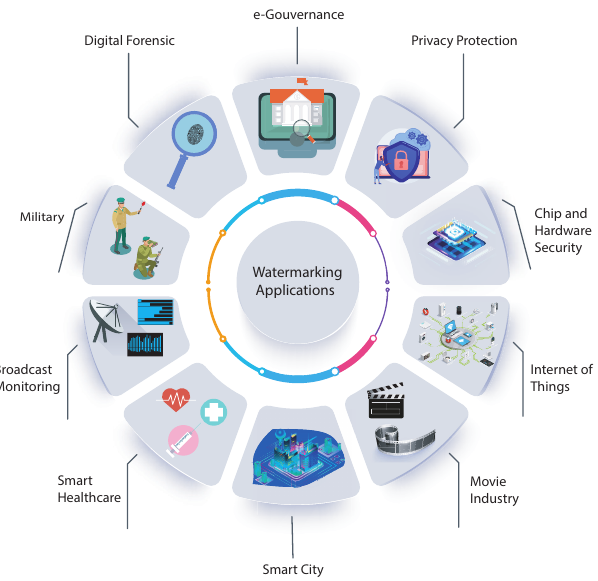
Figure 2. Recent applications of